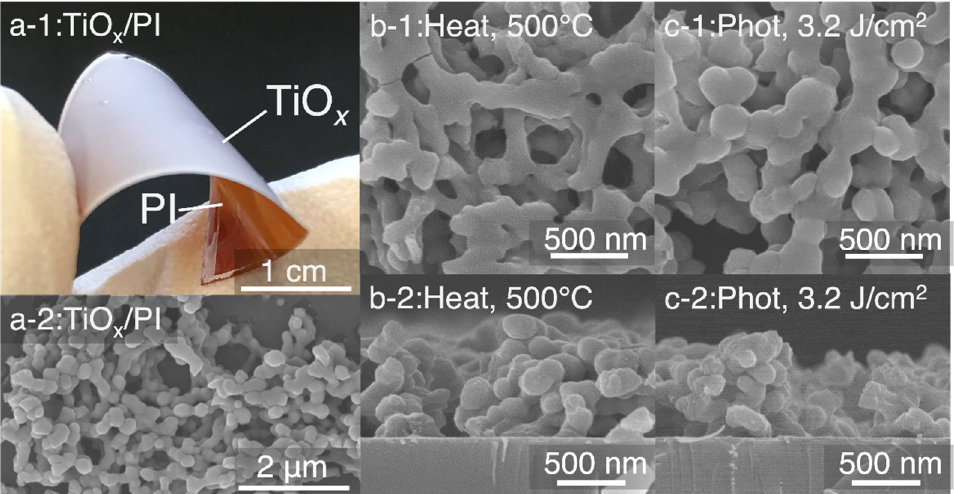
Figure 12. ( a ) Photograph and top view of the SEM images of TiO x nanostructure thin film on PI substrate after photosintering at 3.2 J·cm −2 once on the PI substrate. Top view/cross-sectional view of the SEM images of TiO 2 nanostructures on the rigid SiO 2 glass substrate after ( b ) heat sintering at 500 °C and ( c ) photosintering at 3.2 J·cm −2 one time. Reprinted with permission from Ref. [58]. Copyright 2020 American Chemical Society.